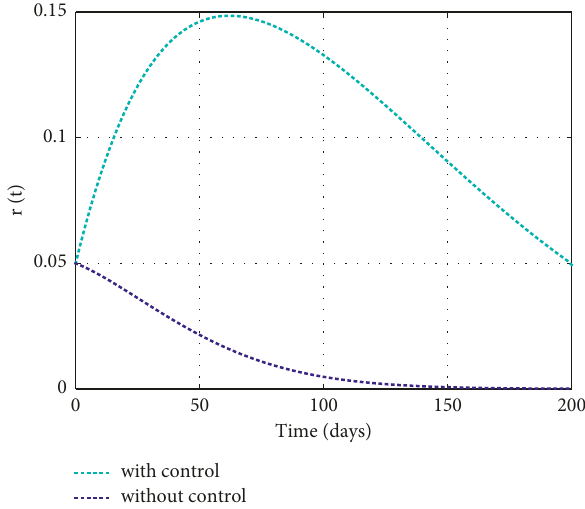
Figure 11: Simulation of cholera recovered and HIV-free